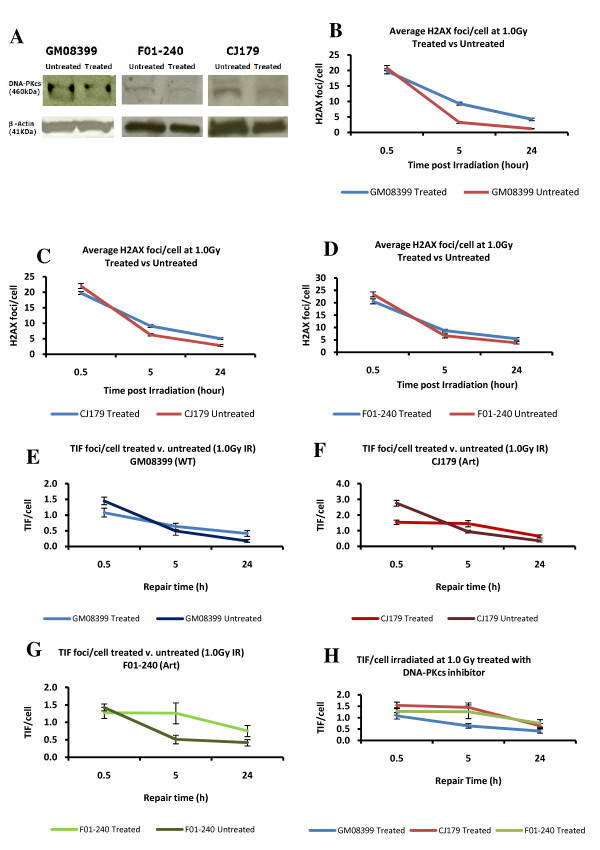
Kinetics of DNA damage repair after DNA-PKcs inhibition. A. Results of Western blotting analysis. A reduction of 45% in DNA-PKcs protein level was observed 24 hrs after treatment of cells with 20 μM/μl of IC86621 based on densitometry analysis (software used: ImageQuant V5.1). B-D. Frequencies of γ-H2AX positive foci per cell after 1.0 Gy of gamma rays before and after DNA-PKcsi treatment. E-H. Frequencies of TIF per cell after 1.0 Gy of gamma rays before and after DNA-PKcsi treatment. The results are based on three independent experiments with at least 100 cell nuclei analysed per experiment per point. Error bars represent SEM in B-D and SD in E-H. CJ179 and F01-240 are Artemis defective cell lines whereas GM08399 is a wild type cell line.